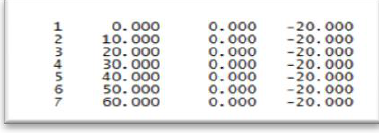
Figure 1. Extract of input data set